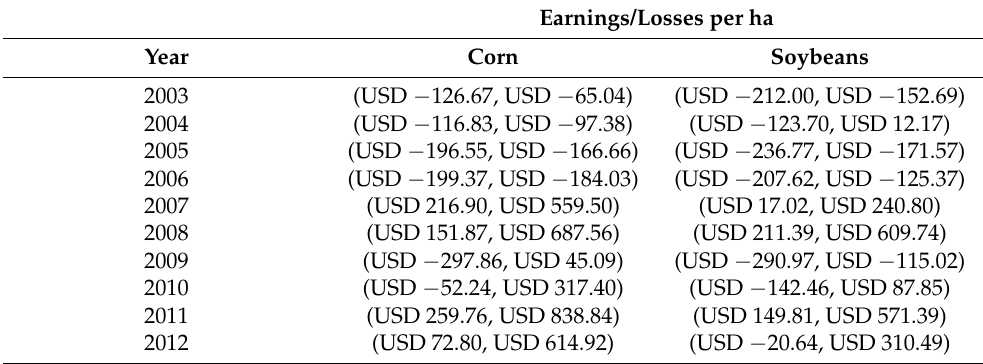
Table 5. Ranges of estimated earnings (+ve) or losses ( − ve) per ha for 2003–2012 for a medium-sized farm in